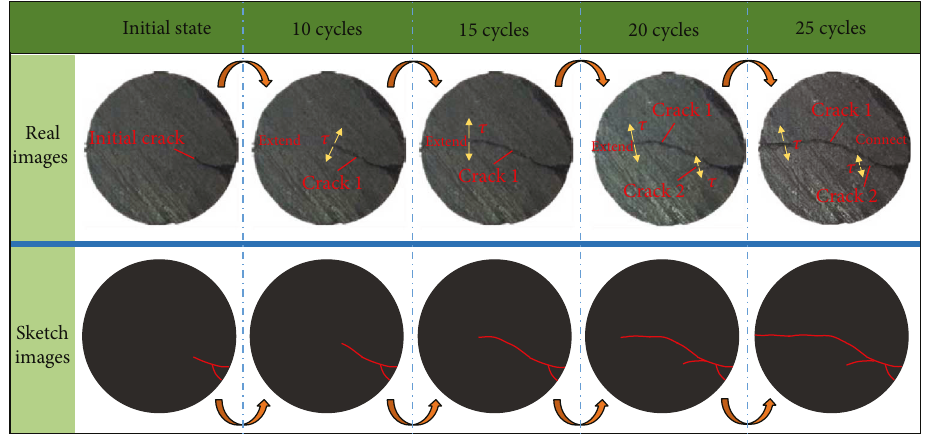
Figure 10: Propagation of a surface crack of sx-1 in forms of real images and sketch